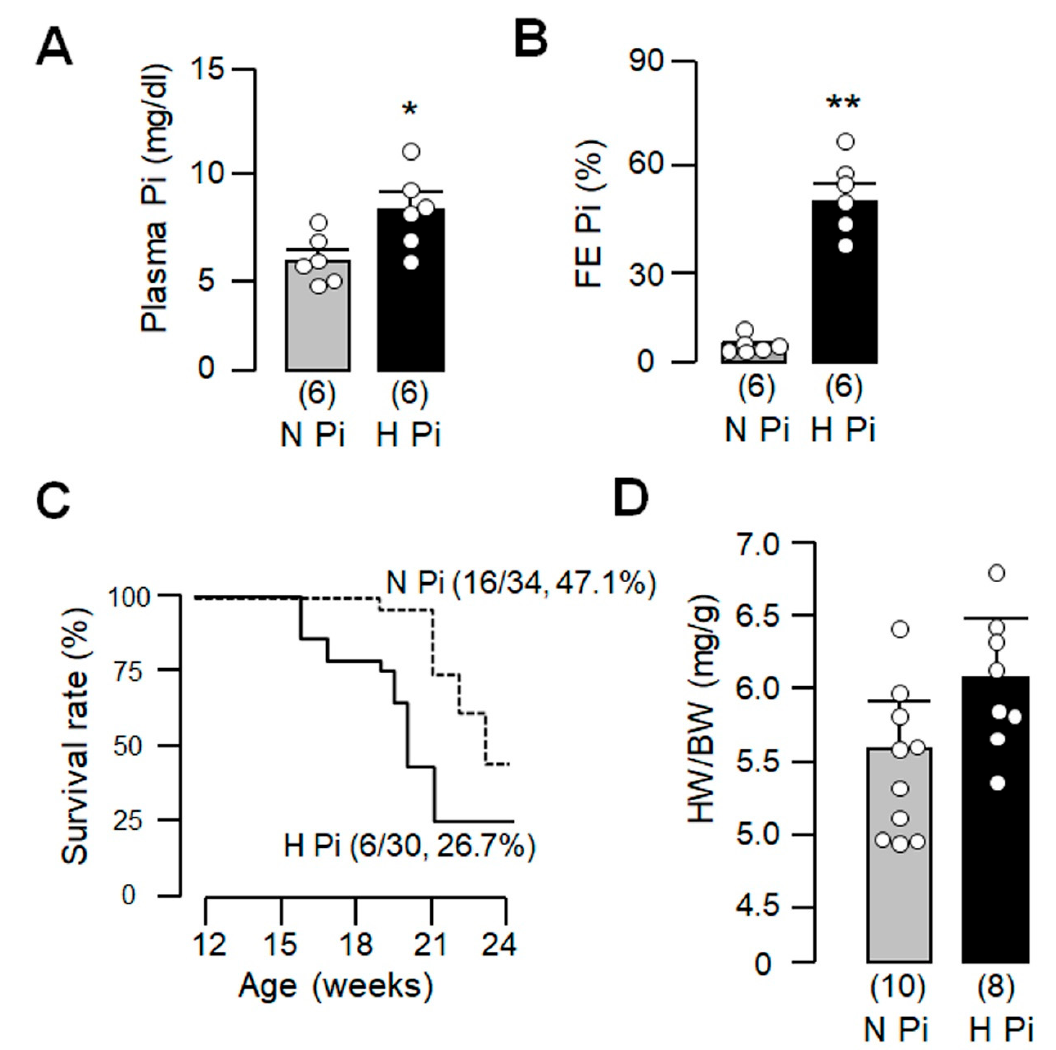
Figure 4. High dietary phosphate increased mortality in H-atg5 − / − mice. H-atg5 − / − mice were fed with normal- or high-phosphate diet starting at 12 weeks old for 12 weeks. ( A ) Plasma phosphate (Pi) concentration after 12-week dietary phosphate treatment in H-atg5 − / − mice; ( B ) Fractional excretion of phosphate after 12-week dietary phosphate treatment; ( C ) Kaplan–Meier survival curves of H-atg5 − / − mice fed with normal- or high-phosphate diet; ( D ) Heart weight/body weight in H-atg5 − / − mice fed with normal- or high-phosphate diet for 12 weeks. Sample number in each group is presented in brackets underneath corresponding bar. Quantitative data are presented as mean ± SD with scatter plots of individual data points, and statistical significance was assessed by unpaired Student’s t -test. Significant differences were accepted when * p < 0.05 or ** p < 0.01 between groups. FE Pi : fractional excretion of phosphate; H Pi: high-phosphate diet; N Pi: normal-phosphate diet.